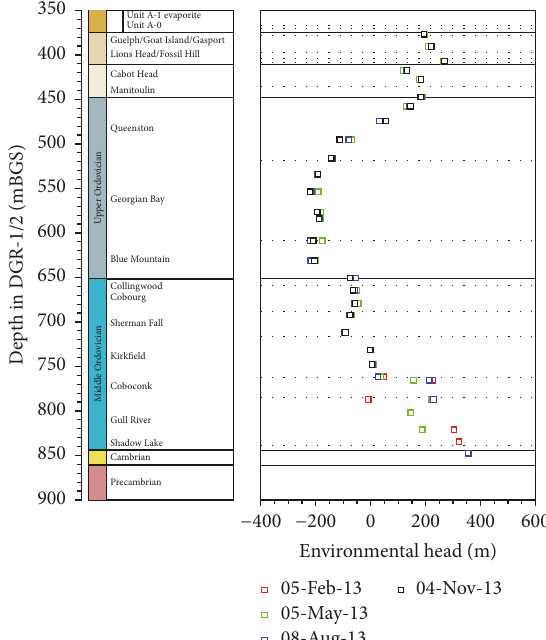
Figure 3: Environmental head profiles in DGR-4 for four sampling periods in